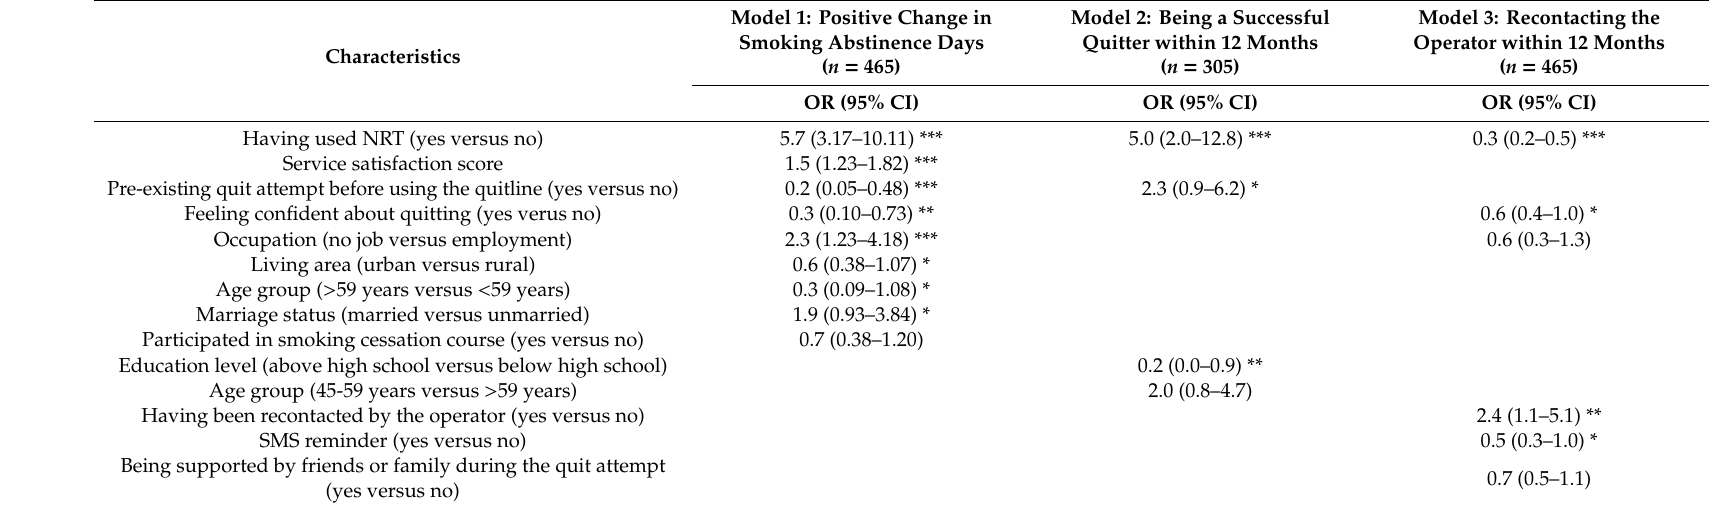
Table 4. Factors associated with the quitline